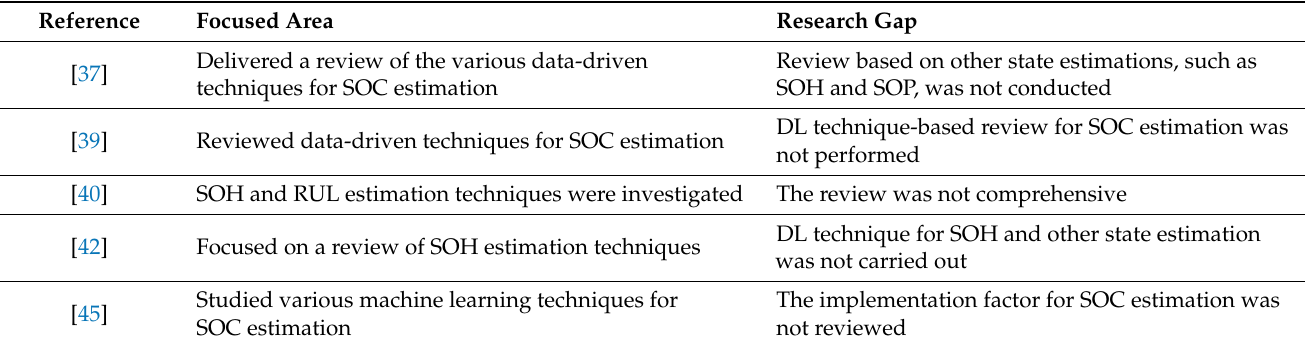
Table 1. Focused area and research gaps of the existing